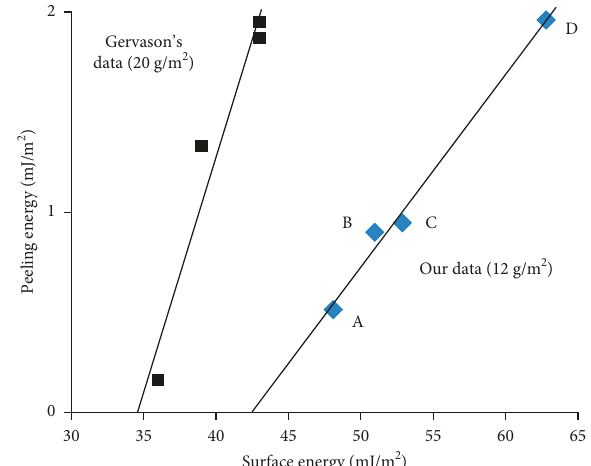
Figure 6: Peeling energy ( δ ) of the polyethylene as a function of the surface energy of the top of the paperboard coated with (A) nonpolar latex without flame treatment, (B) nonpolar latex with flame treatment, (C) polar latex without flame treatment, and (D) polar latex with flame